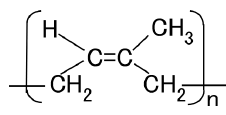
Figure 12. Scheme of polyisoprene structure of NR-latex.